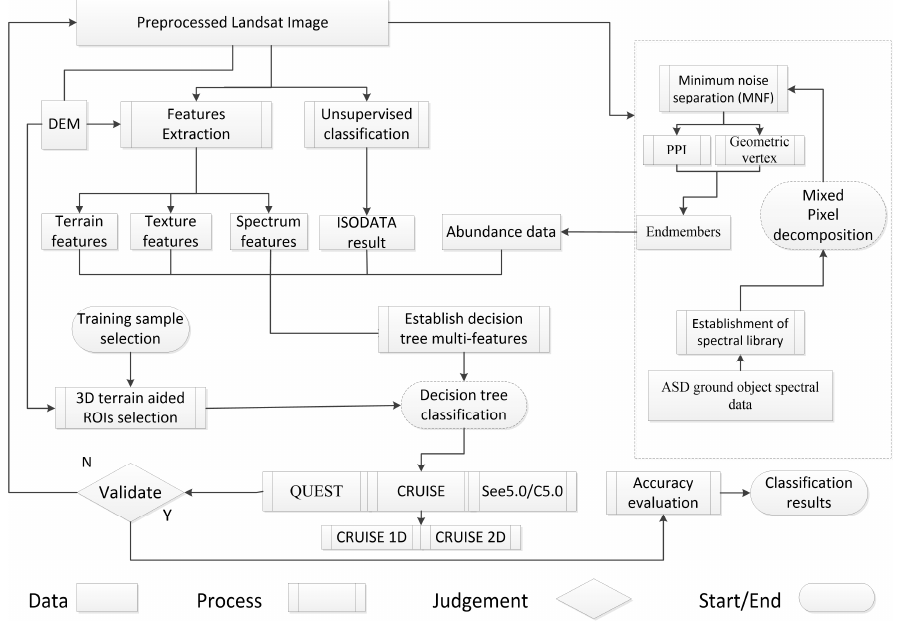
Figure 2. Methodological framework for proposed improved decision tree method. The abundance